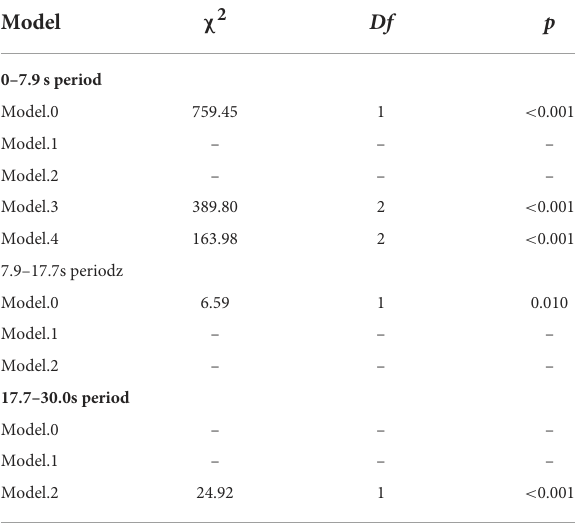
TABLE 4 Pupil diameter GCA model comparisons.